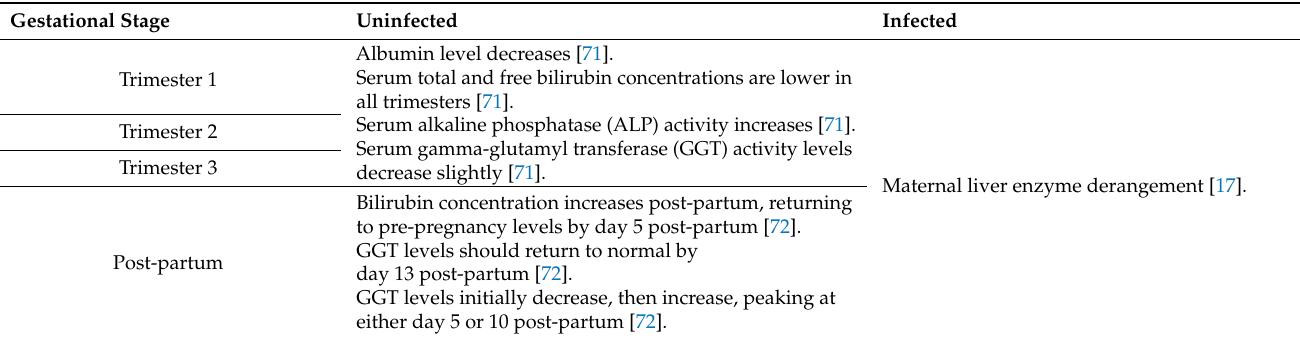
Table 5. Uninfected versus dengue-infected hepatobiliary changes in pregnant women.